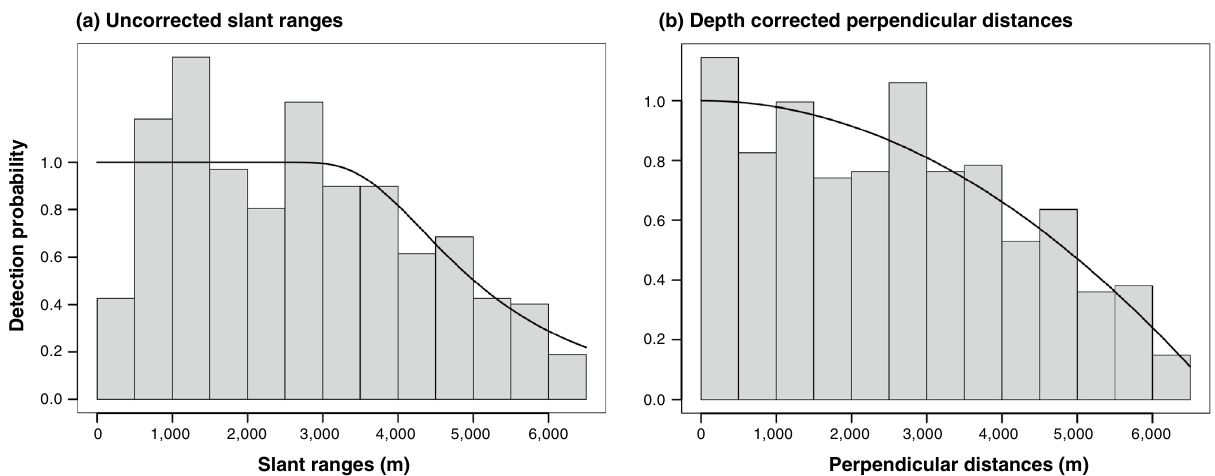
Slant ranges (m) Figure 8. Fitted line transect models for acoustic detections of sperm whales (n = 431) truncated at 6500 m. The solid line represents the best fitting model. The histogram bars represent the ( a ) perpendicular slant range with a fitted hazard rate key function with no adjustment terms or ( b ) depth-corrected perpendicular horizontal distance with a fitted half normal key function with simple polynomial adjustment terms of order